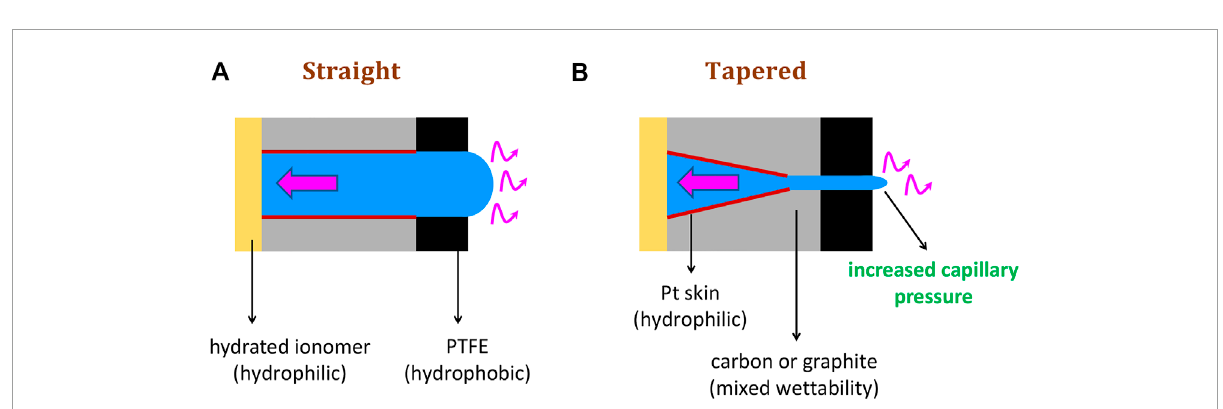
FIGURE 3 (A) Variation of the normalized saturation pressure, ̃ p sat H θ = 30 ° (≈ Pt ), 60 °, 80 ° (≈ C), corresponding to T = 60 ° C. (B) Variation of the removal water vapor flux at the CL/MPL interface, N out H temperature, T , for three different pore radii, R = 2 , 10 , 50 nm, corresponding to θ = 80 ° . The water flux due to ORR generation and crossover from anode to cathode ( β = 0 . 2 ) is also included for comparison (dashed line). Other parameters: s avg = 0 . 6, ɛ = 0 . 4, k eff ( s avg ) = 0 . 3 W m −1 K −1 , ̇ Q = 3 kW −2 .